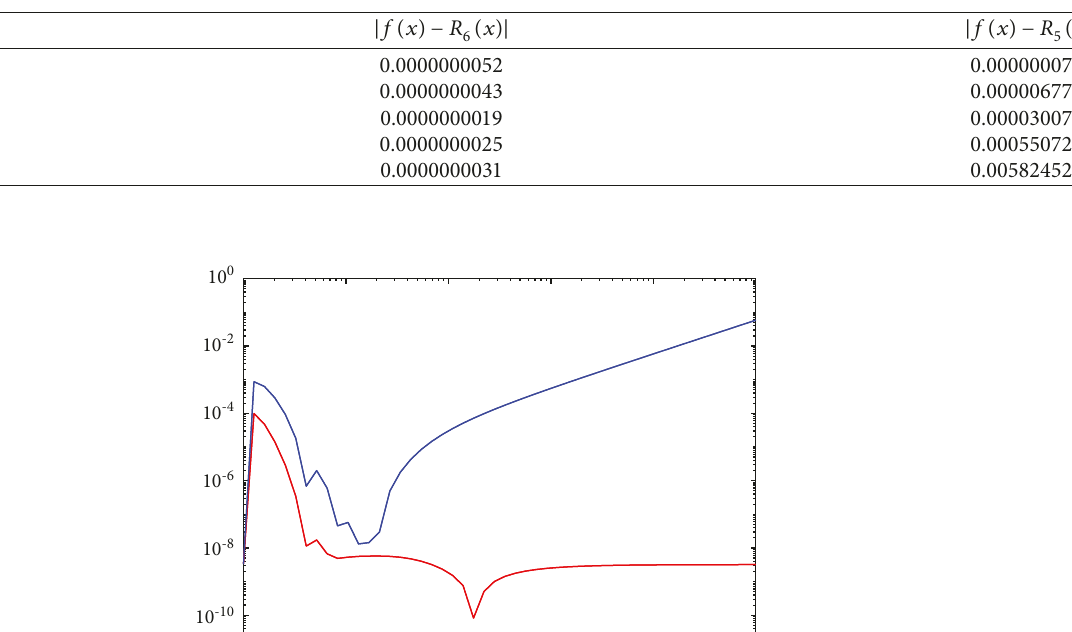
Figure 1: Function plots of f ( x ) and R Table 2: Numerical experiments about the error.